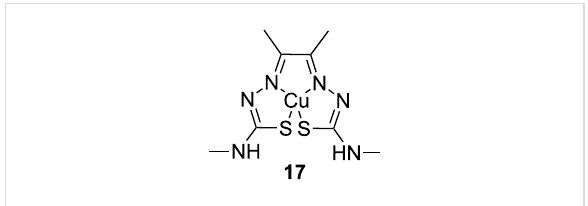
Figure 9: Cu(II)(atsm), an example of a Cu(II)(btsc) copper complex.